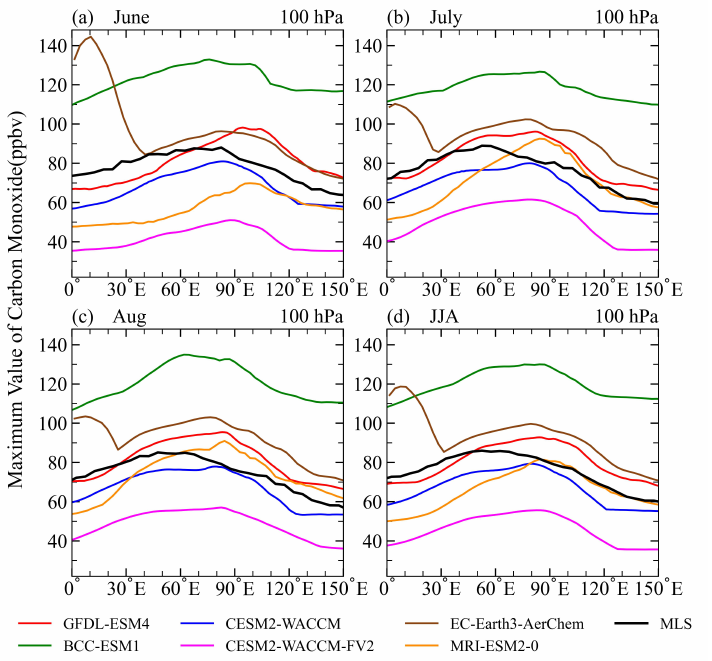
Figure 4. Maximum CO values between 0 ◦ –60 ◦ N for JJA seasonal mean and monthly means of June, July and August from CMIP6 models and MLS observations at 100 hPa during 2005–2014 (Unit: